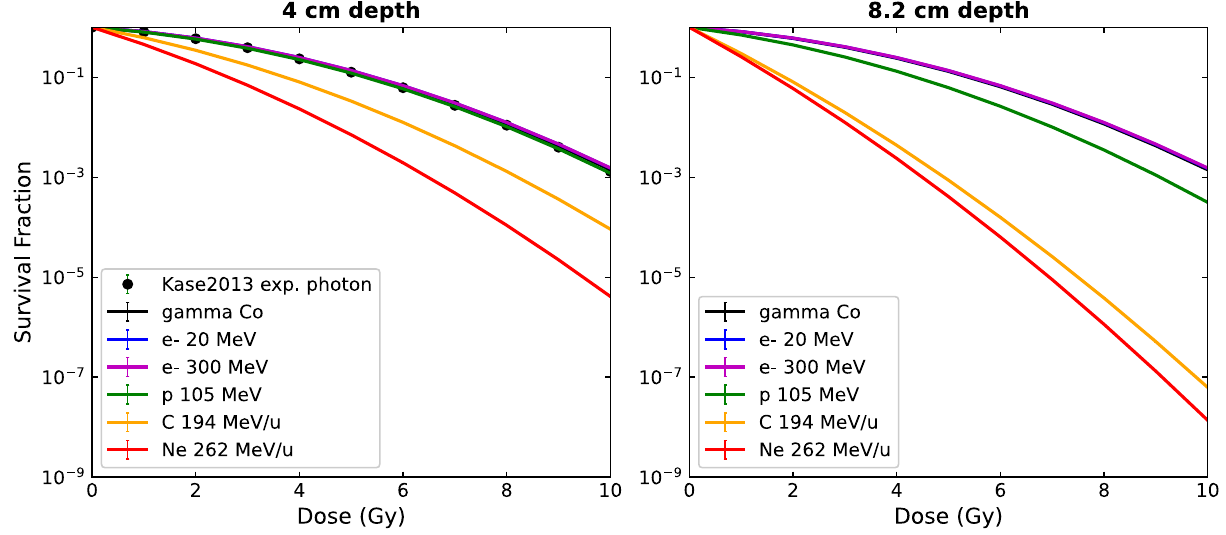
Figure 7. Theoretical survival curves calculated for different particles at a depth of 4 (left) and 8.2 (right) in colored lines. Experimental cell survival curve for HSG cells exposed to photons represented with black points 39